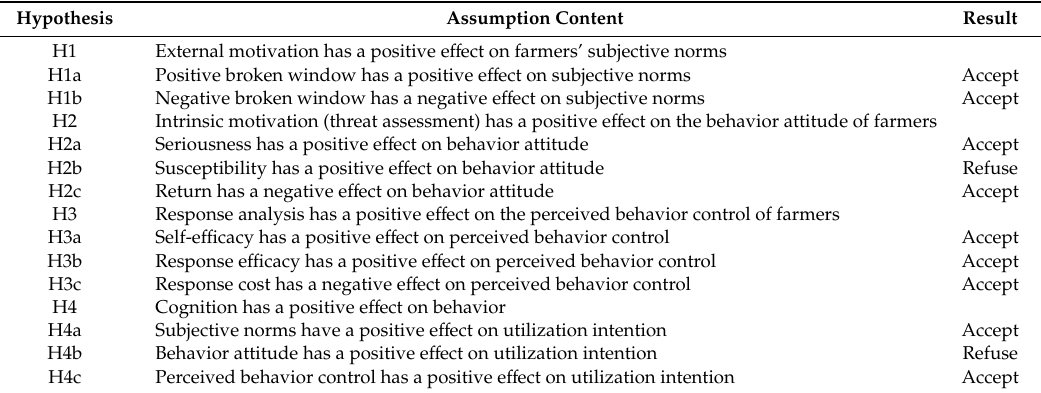
Table 3. Hypothetical